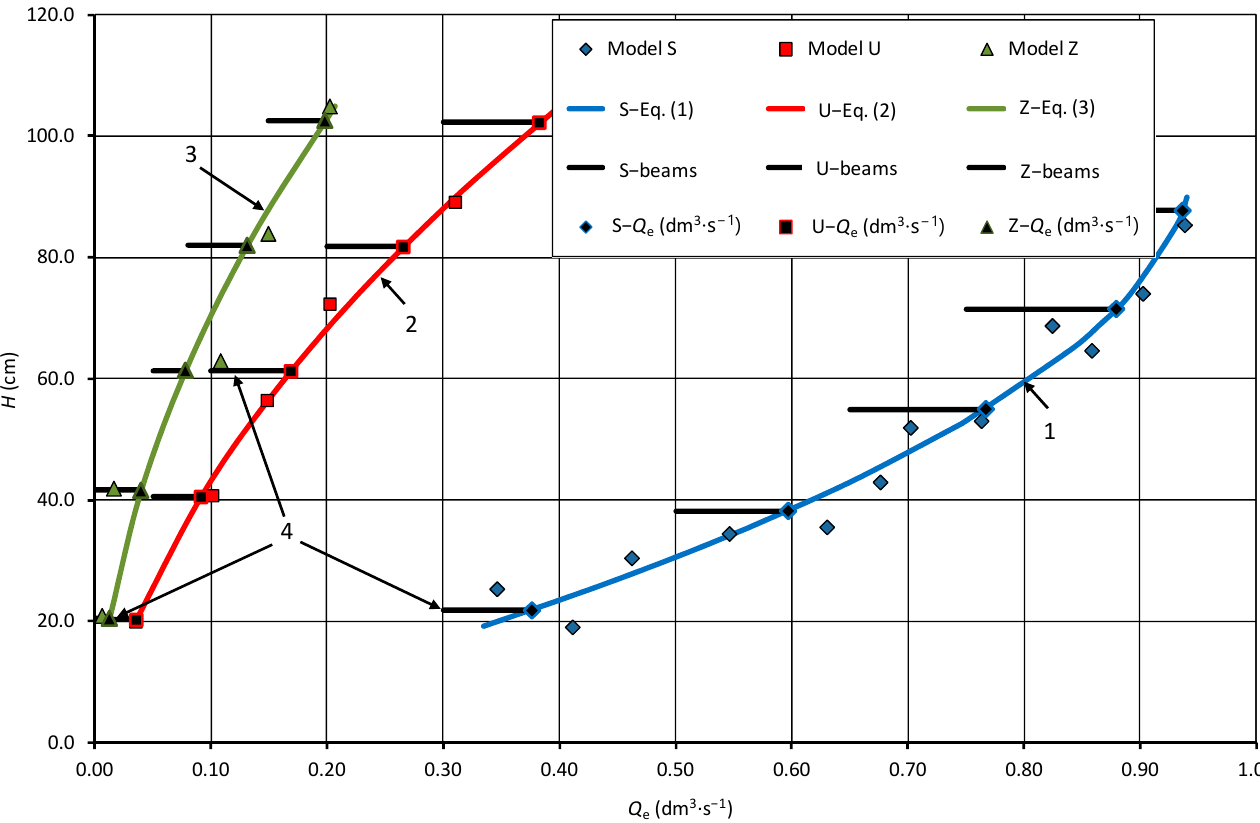
Figure 6. Effective flow Q e of the tested regulators depending on the water depth H : 1—S model; 2—U model; 3—Z model; 4—levels of the upper edges of the beams.